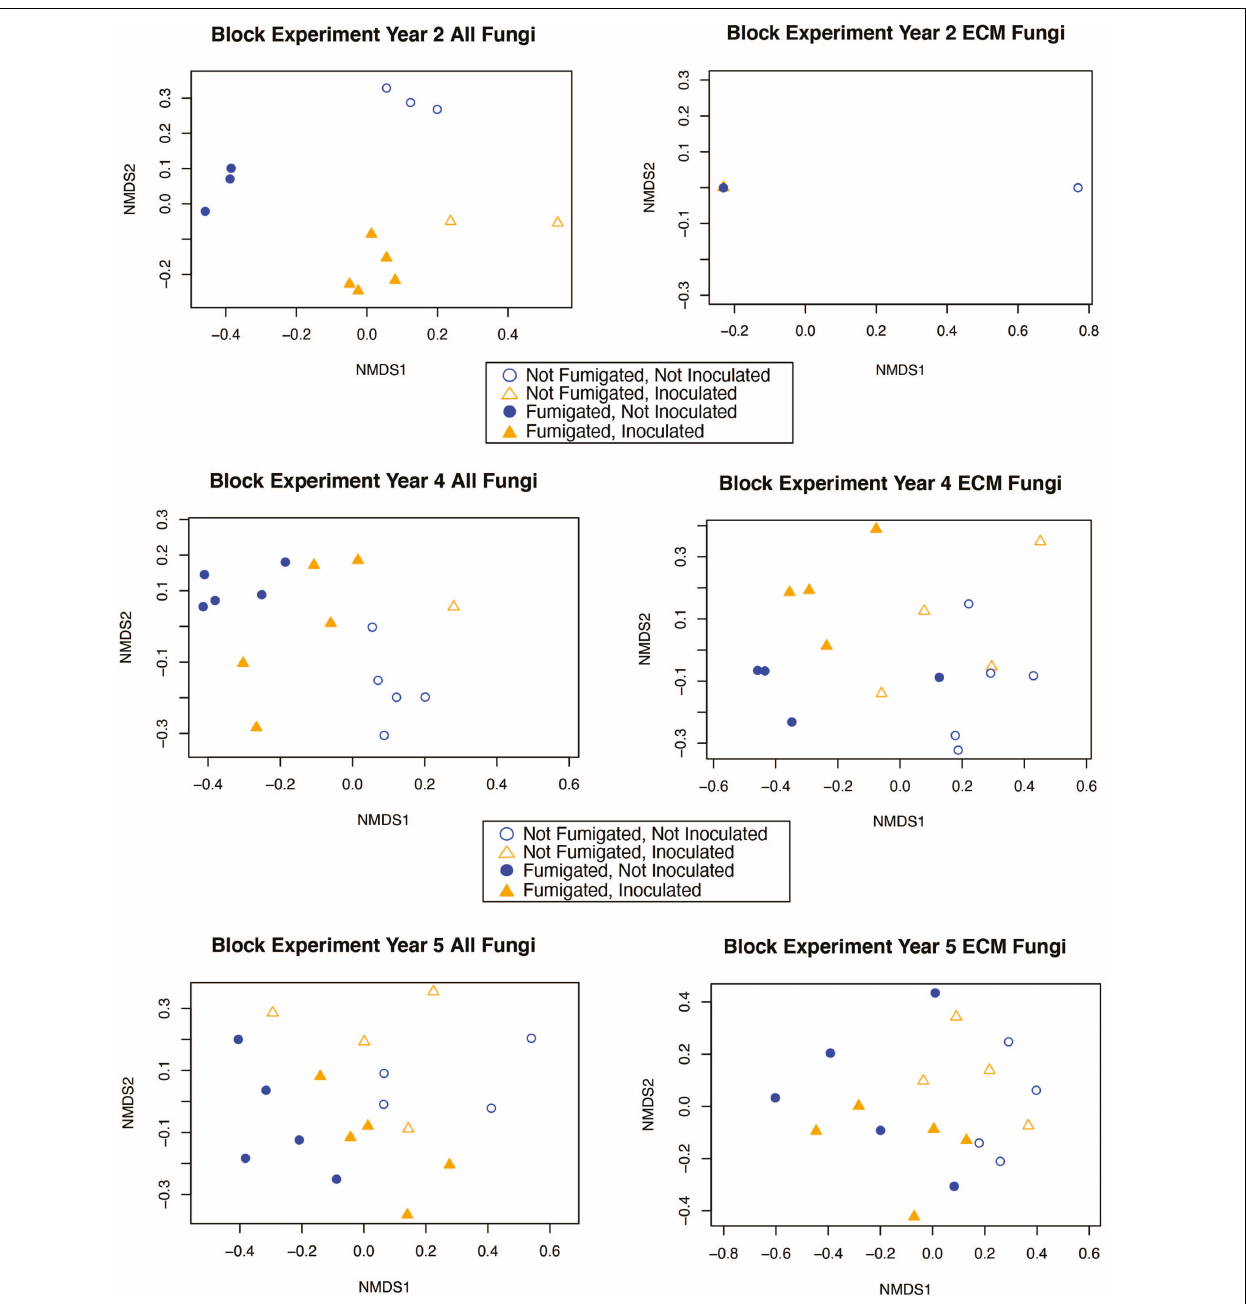
FIGURE 2 | NMDS ordination for the fumigation and inoculation block experiment with both the “all fungi” and “ECM fungi only” datasets using the Raup-Crick distance metric, stress < 0.2, and 2–3 dimensions.